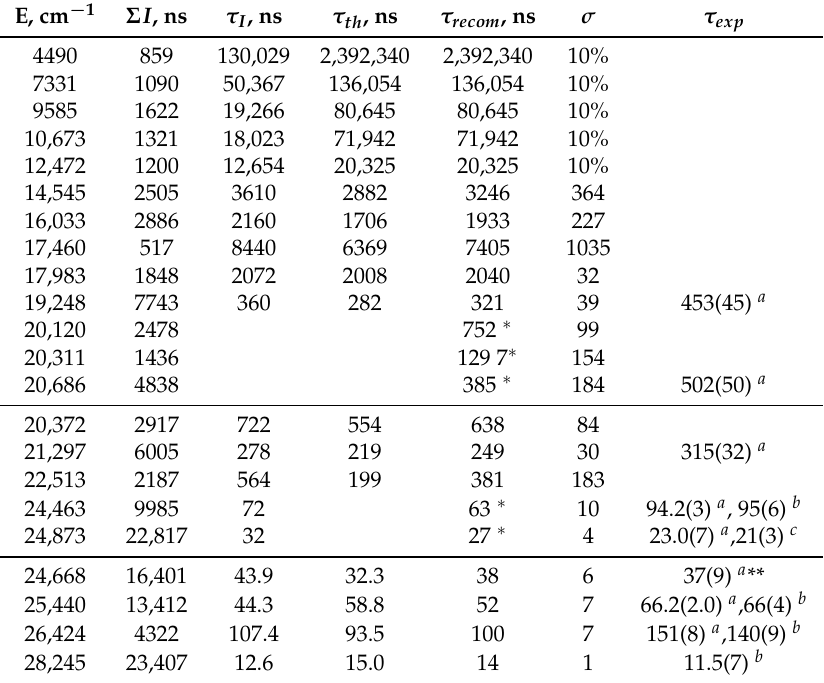
Table 6. Comparison between lifetimes “ τ th ” calculated with configuration–interaction many-body perturbation theory (CI-MBPT) and lifetimes τ I derived from the sum of intensities for J=2.5 odd Th II states. The difference allows us to estimate the error of calculations. When strong mixing occurs, the average lifetimes are compared (below the horizontal line), and the intensities are used to obtain individual lifetimes (*) from branching ratios. Theoretical lowest-energy lifetimes are expected to be quite reliable, so the intensities were not used for the recommended value, especially because some systematic effects can be present. A 10% error is assigned from the analysis of the data at higher energies. The directly-measured experimental lifetimes are taken from: a [5], b [6], c [4]. In case of mixing, one averaged experimental lifetime (**) was compared with the averaged recommended lifetime. E, cm − 1 Σ I ,